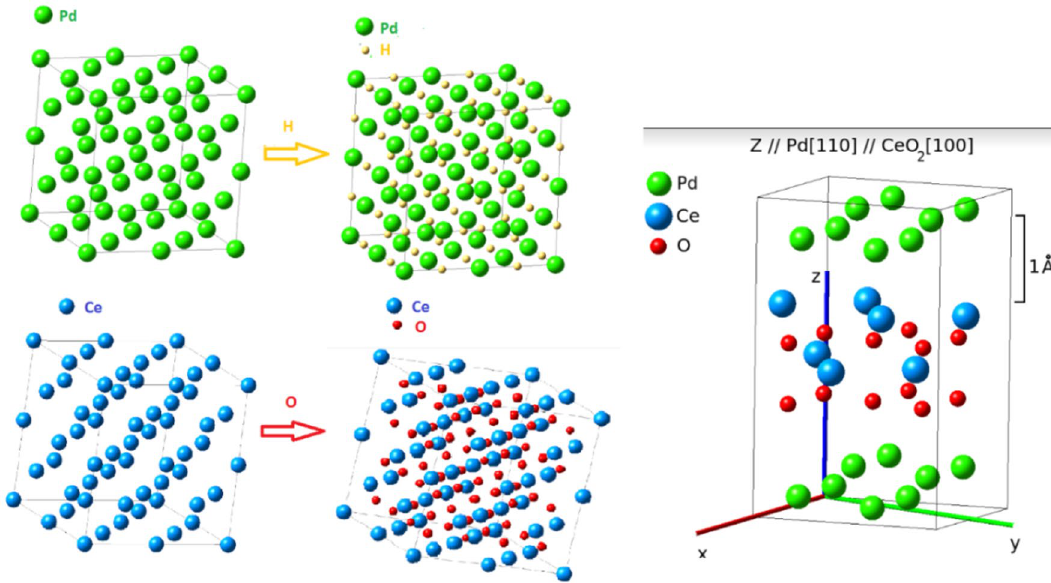
Figure 7. Crystalline cells of Pd and Pd-hydride, CeO 2 , PdCeO 2 and Pd-CeO 2 Interface obtained from MEDEA simulation